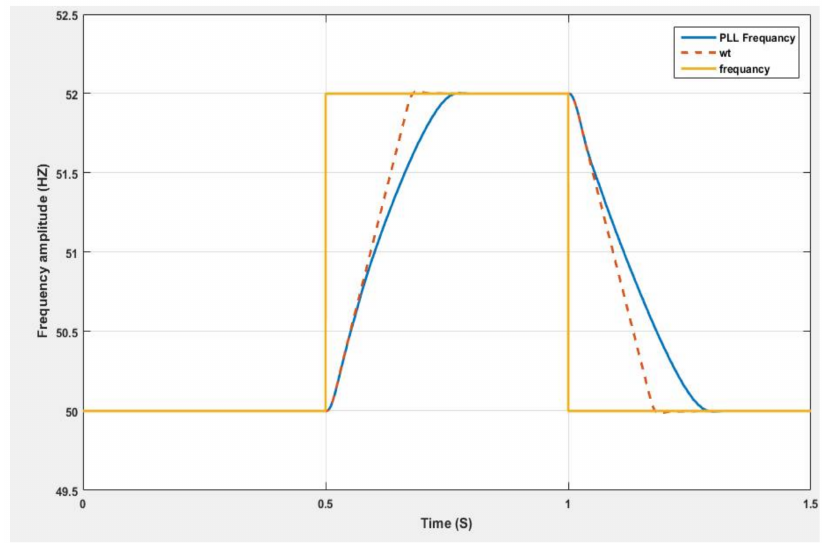
Figure 5. Frequency variation measurements between 50 and 52 Hz.